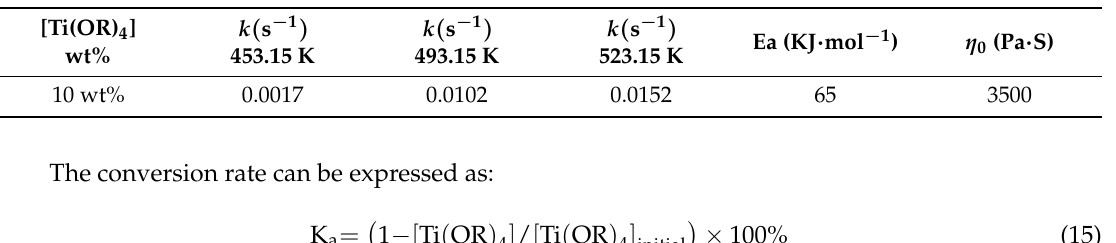
Table 2. The material properties at different